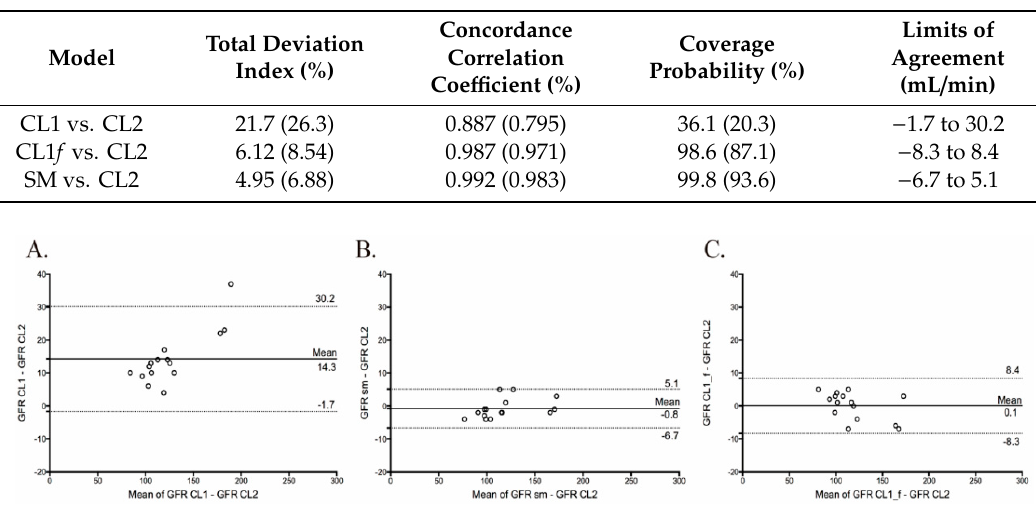
Figure 3. Limits of agreement and Bland–Altman plots for glomerular filtration rate measured (GFR) between the two-compartment model (CL2) with ( A ), the one-compartment (CL1), ( B ) the simplified two-compartment model (SM) and ( C ) the one-compartment adjusted by a formula (CL1 f ). The procedure compares the di ff erence between two methods versus the di ff erence of the means of both methods. The straight and dashed lines indicate mean di ff erence and 95% limits of agreement, respectively.